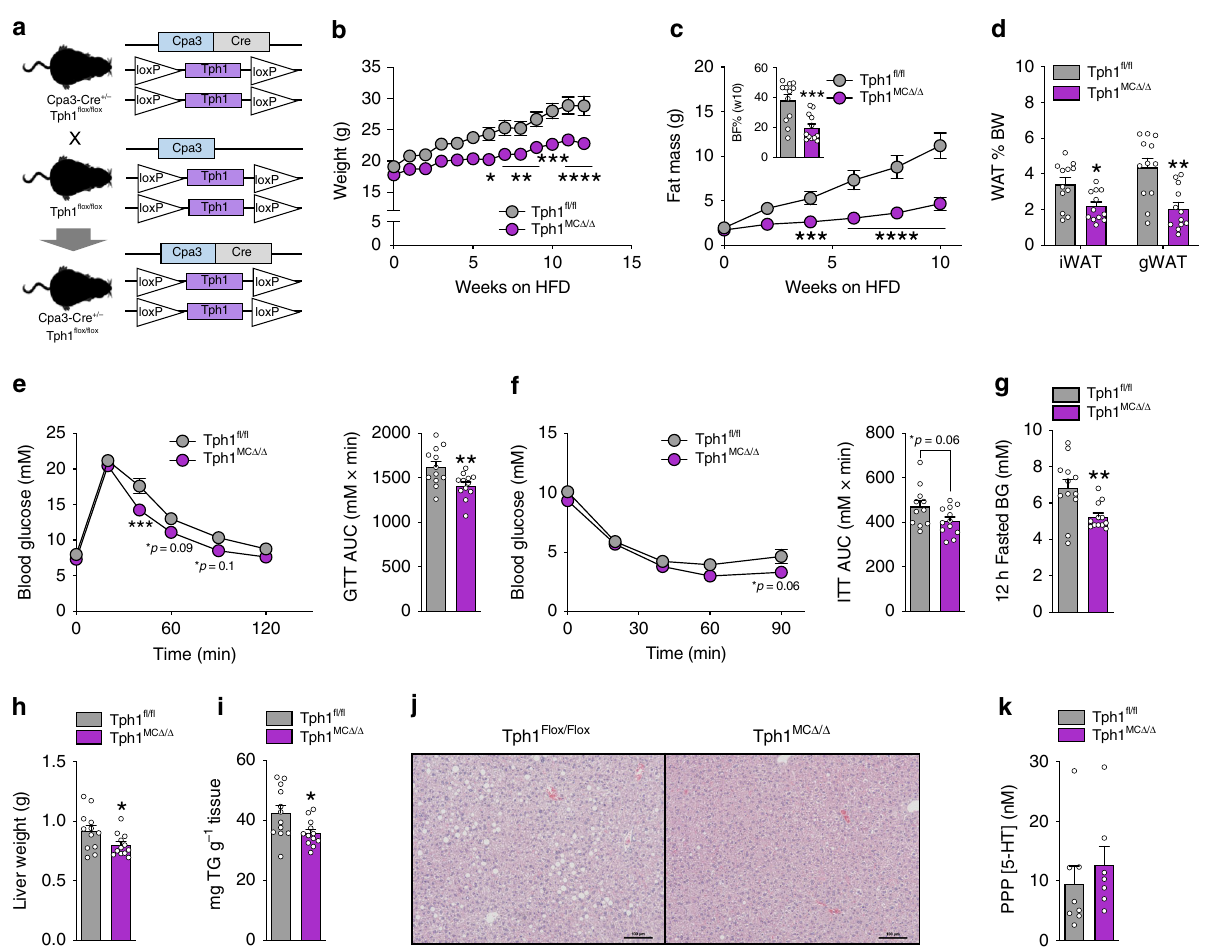
Fig. 3 Mast cell-speci fi c Tph1 deletion protects HFD-fed mice from obesity and insulin resistance. a Breeding strategy to produce Carboxypeptidase-3 (Cpa3) Cre Tph1 double fl oxed mice. b Weight and c Fat mass over time ( n = 12). d WAT mass % of body weight ( n = 12). e Glucose tolerance test (GTT), 1.5 g/kg glucose ( n = 12). f Insulin tolerance test (ITT), 1 U/kg insulin ( n = 12). g Overnight 12 h fasted blood glucose (BG, n = 12). h Liver weight in grams ( n = 12). i mg of Triglycerides (TG) per gram of liver tissue ( n = 12). j Representative liver H & E images, scale bar 100 µ m. k Serotonin concentration in platelet poor plasma (PPP) samples ( n = 8 Tph1 fl / fl , 7 Tph1 MCKO). Statistical signi fi cance ( *p < 0.05, **p < 0.01, ***p < 0.001, ****p < 0.0001) determined by two - way RM ANOVA with Bonferroni post-test or Student ’ s t- test. All data are expressed as mean ±